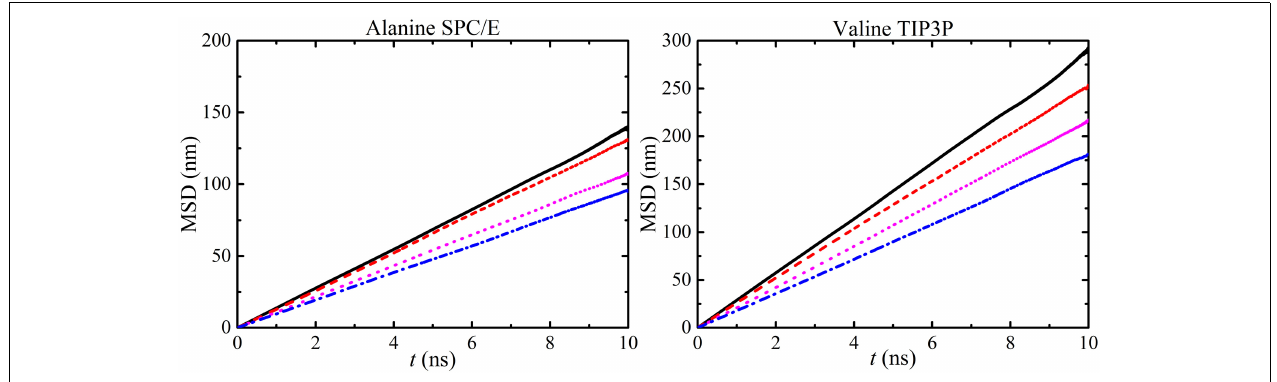
models respectively. The linearity of MSD plots decrease with concentration and similar graphs were also obtained for other amino acid